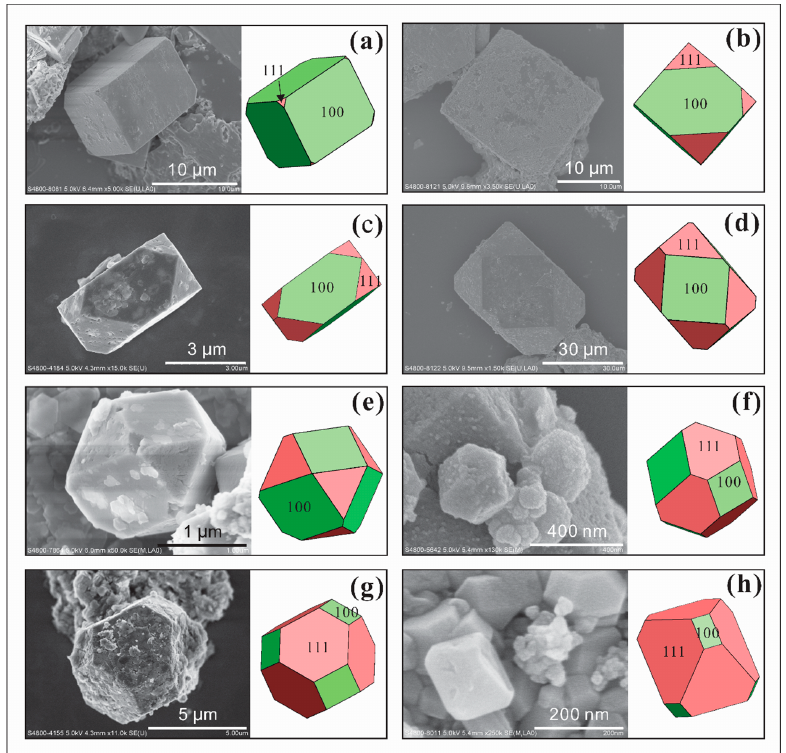
Figure 5. SEM images of single pyrite with combinations of a{100} and o{111} faces and their corresponding crystal shapes (color drawings on the right), indicating preferential orientation growth in the (100) and (111) directions from ( a – h ). ( a ) Pyrite crystals have smooth surfaces. ( b , d , g ) Pyrite crystals covered by clay minerals. ( c, e ) Etching pits on the pyrite crystal surface, especially on faces of o{111}.